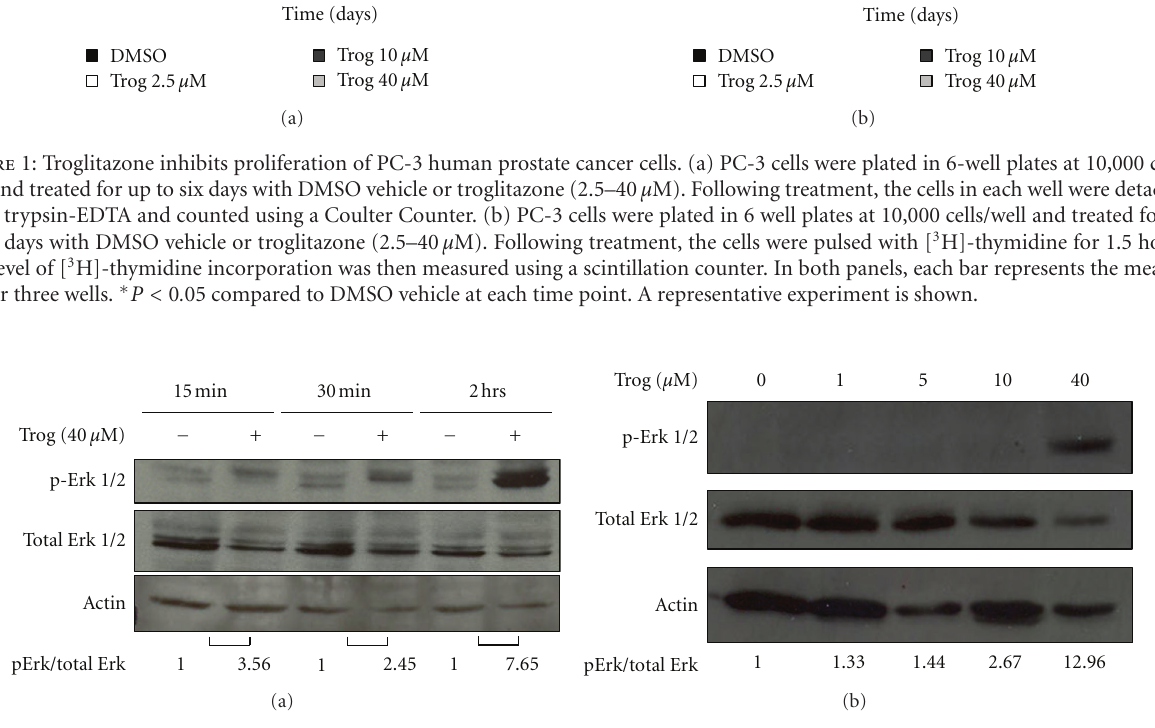
Figure 2: Troglitazone induces phosphorylation of ERK 1/2 MAPK in human prostate cancer cells. (a) PC-3 cells plated in serum free DMEM/F-12 media were treated with DMSO vehicle ( − ) or troglitazone 40 μ M (+) for di ff erent times (0–2 hours). The level of phosphoryla- ted Erk 1/2, total ERK 1/2, and actin in treated cells was then measured by western blot. The data from each blot was quantified using the UN-SCAN-IT program and expressed related to the signal present in control cells for each time point. (b) PC-3 cells were treated for two hours with either DMSO vehicle or varying concentrations of troglitazone (1–40 μ M). Western blotting was used to measure the level of phosphorylated and total ERK 1/2 as well as actin protein in treated